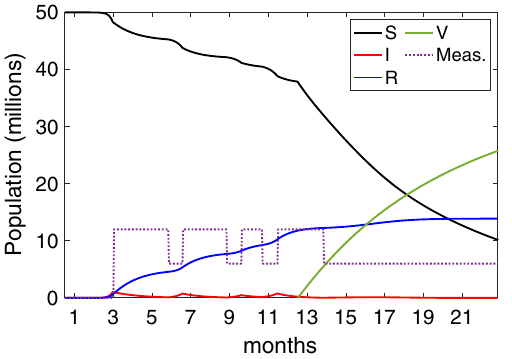
Figure 3. Real scenario for digital contact tracing showing the epidemic dynamics. Note the measures ( meas. ) line represents three levels of intensity, and it is not related to the